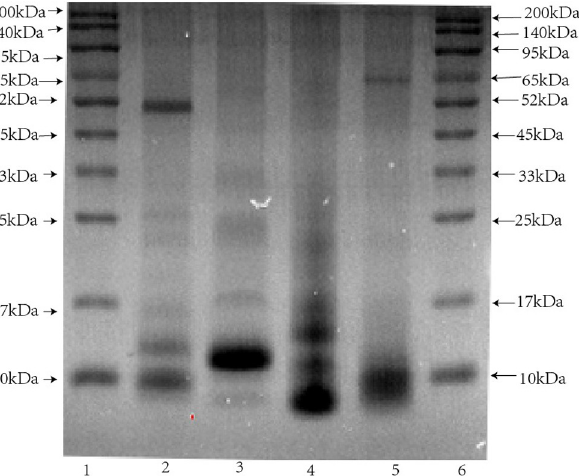
Fig 3. Electrophoretic profile of four venoms. SDS-PAGE (12.5% reducing condition) performed to assess the protein profiles of four venoms, and bands stained with Coomassie brilliant blue G-250. Lanes 1 and 6: standard protein marker, indicating protein MW marker. Lanes 2, 3, 4, and 5 depict BM, BF, NA, and OH venoms, respectively. The arrows depict the MW in kilodalton (kDa).